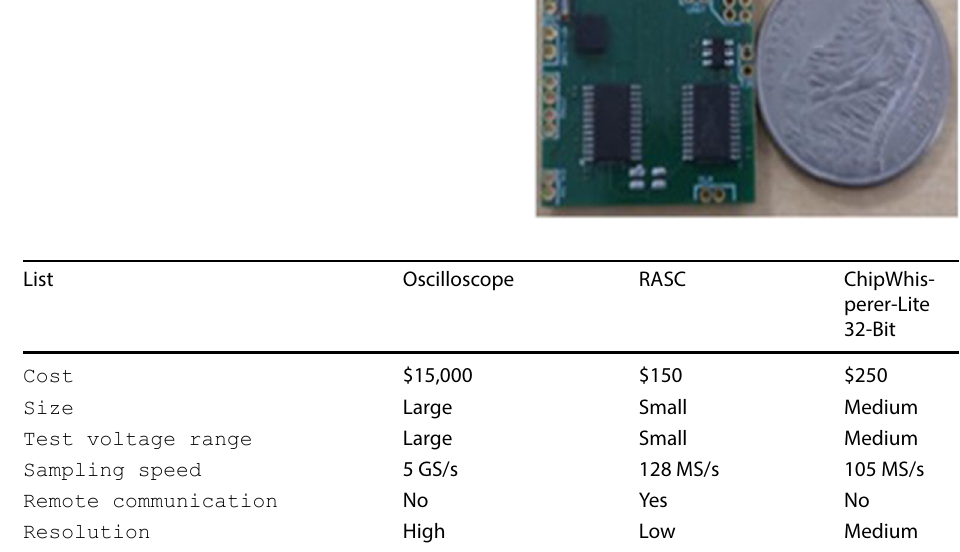
Fig. 4 Dimensions compari- son between RASC and a US quarter